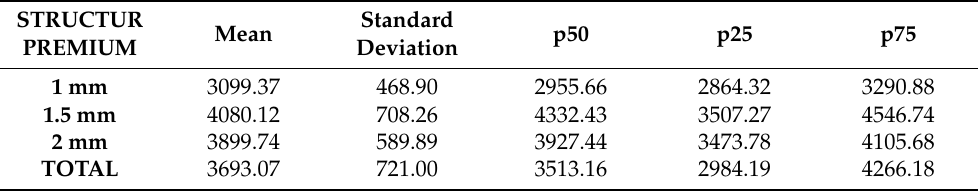
Table 2. Modulus of elasticity vs. thickness (Structur Premium).